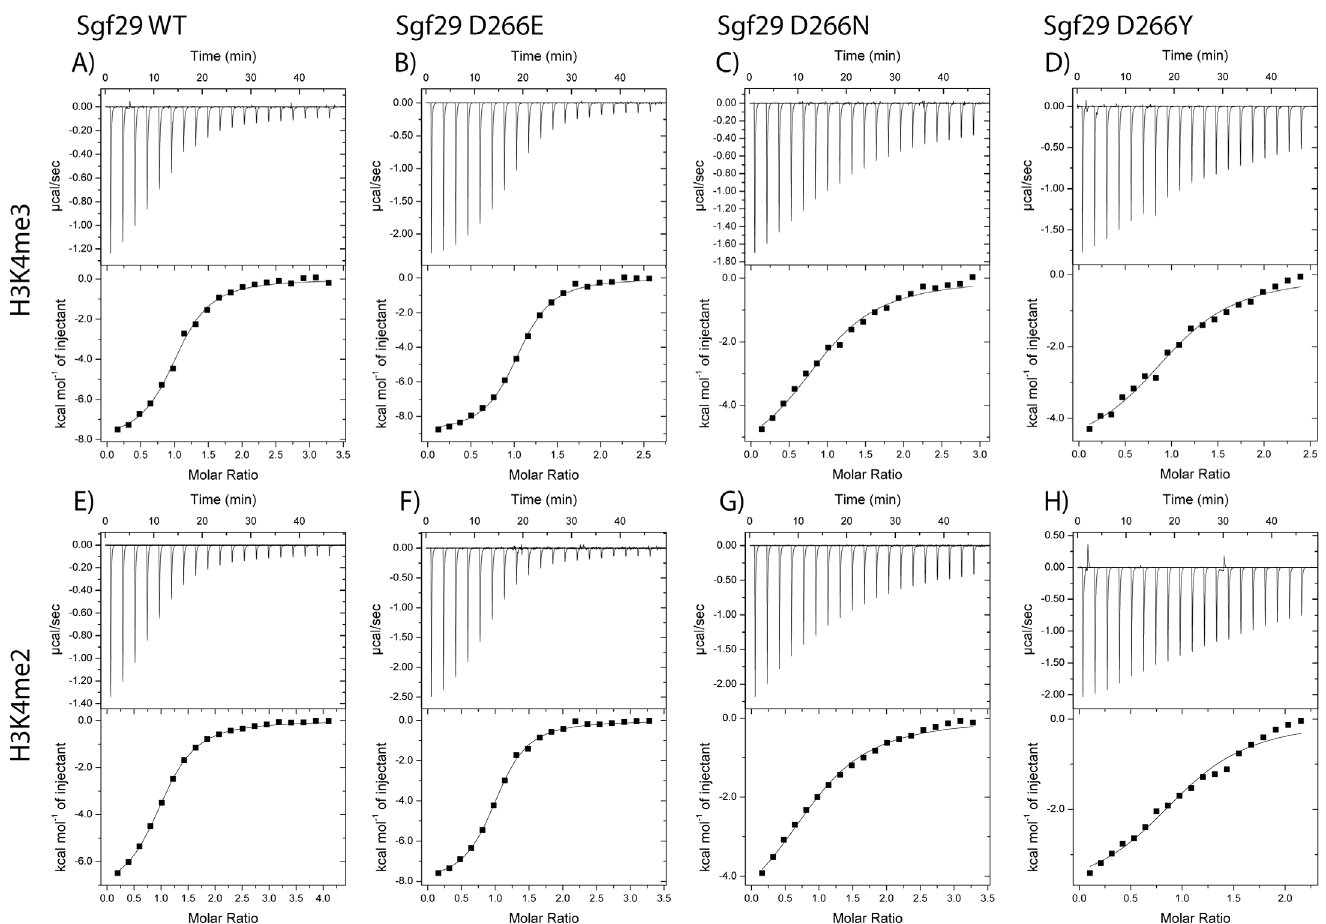
Fig 4. Thermodynamic analyses of Sgf29-H3K4me2 and Sgf29-H3K4me3 interactions. Representative ITC experiments showing the titration of H3K4me3 (top row, A-D) and H3K4me2 (bottom row, E-H) peptides to Sgf29 (first column, A,E), D266E (second column B, F), D266N (third column, C, G) and D266Y (fourth column, D,